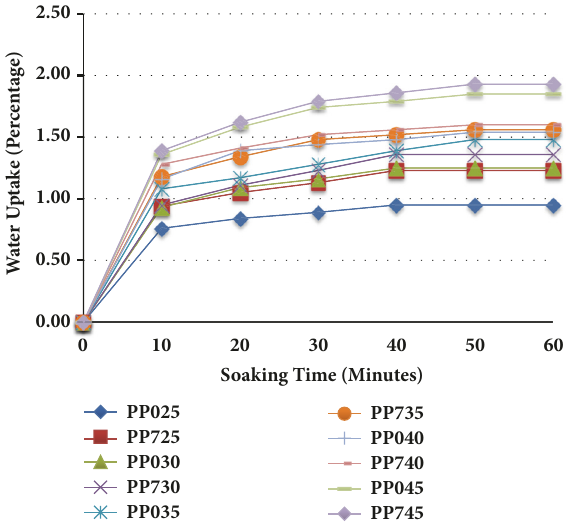
Figure 1: Water uptake percentage of PALF/PP